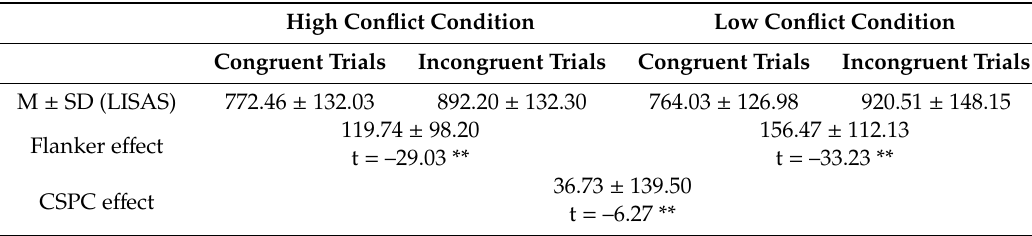
Table 2. Flanker task: Flanker and the context-specific proportion congruent (CSPC) e ff ect.